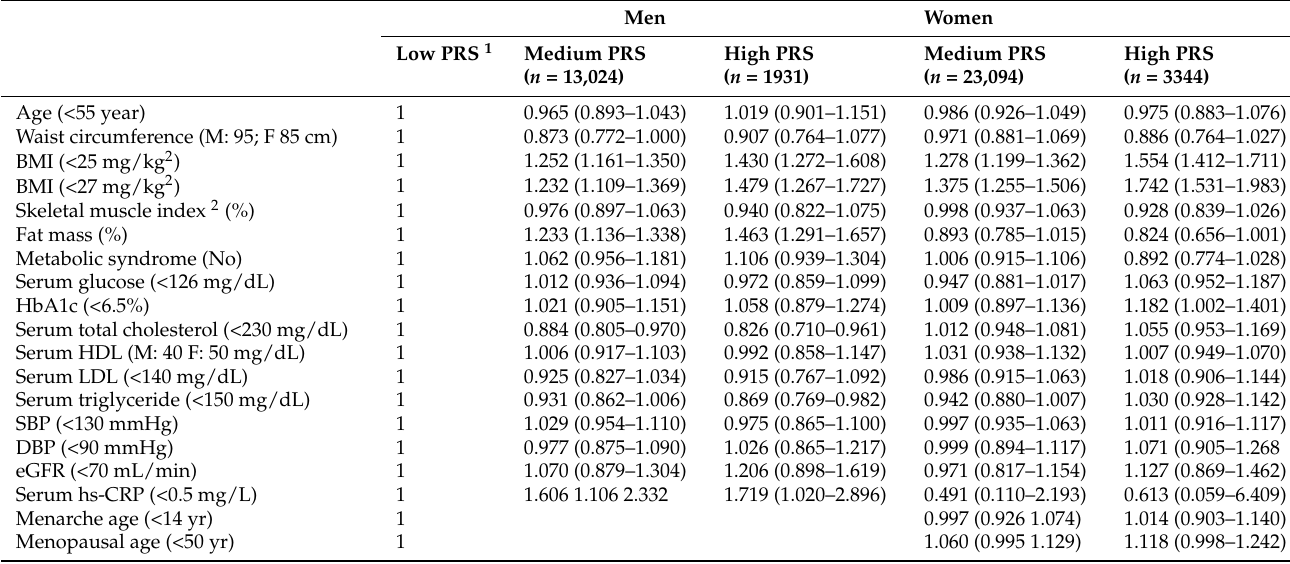
Table 5. Association of polygenetic risk scores (PRS) with metabolic parameters in the participants according to genders and obesity status.